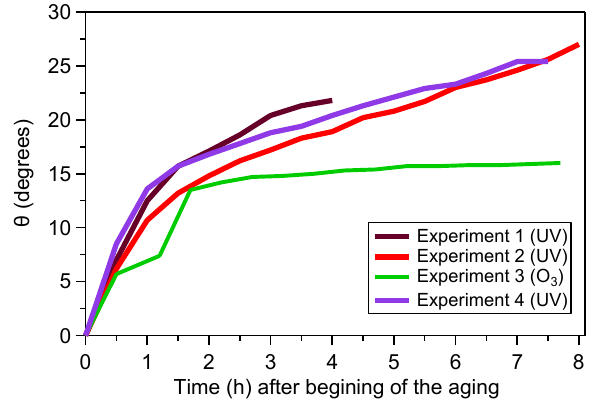
Figure 4. Evolution of the θ angle with the initial AMS mass spec- trum during